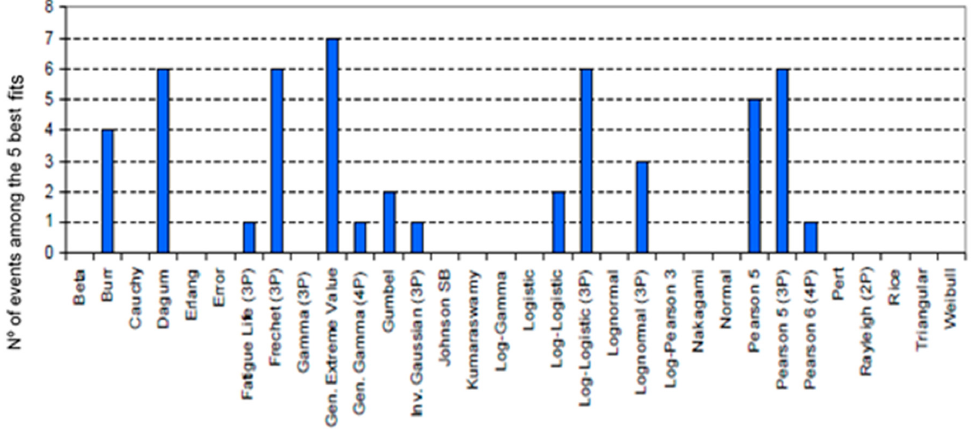
Figure 7. Number of events in the different distributions according to the goodness-of-fit test at the locations for the ten largest simple sizes.